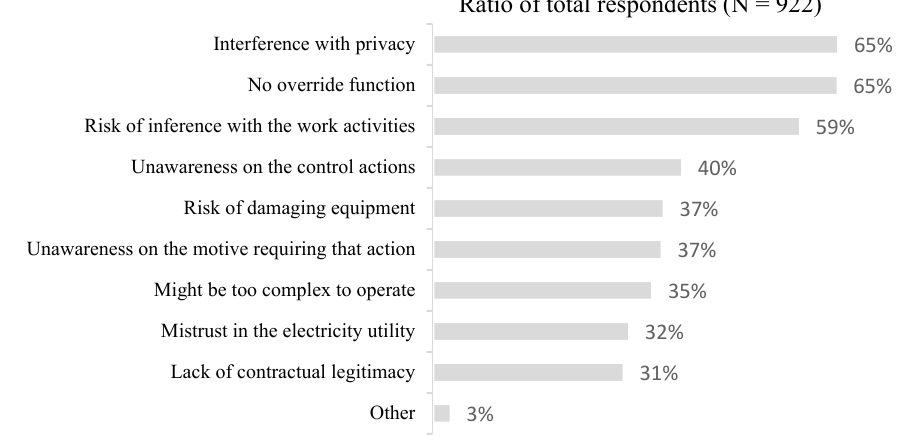
Figure 8. Reasons to not accept the remote control of some appliances by the electricity utility.